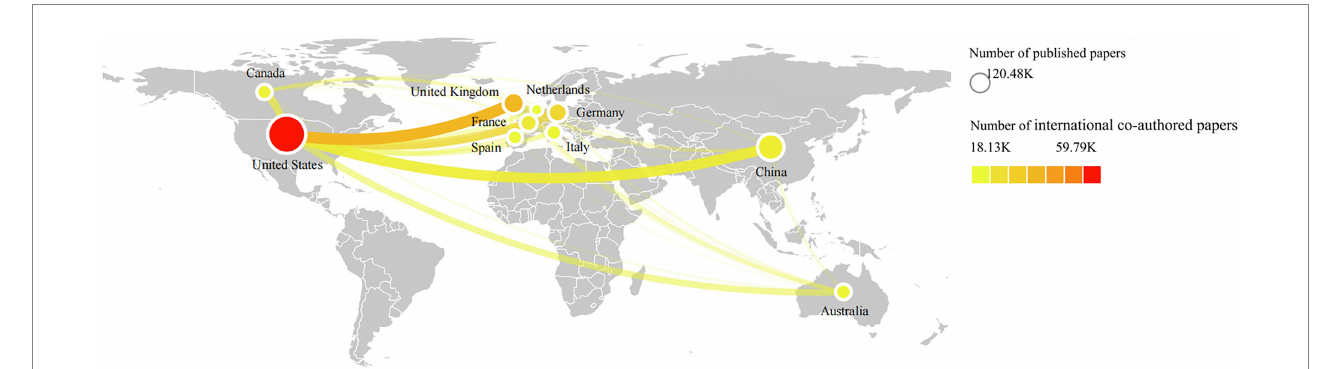
FIGURE 5 Top 10 countries published international co-authored WoS papers using genetic